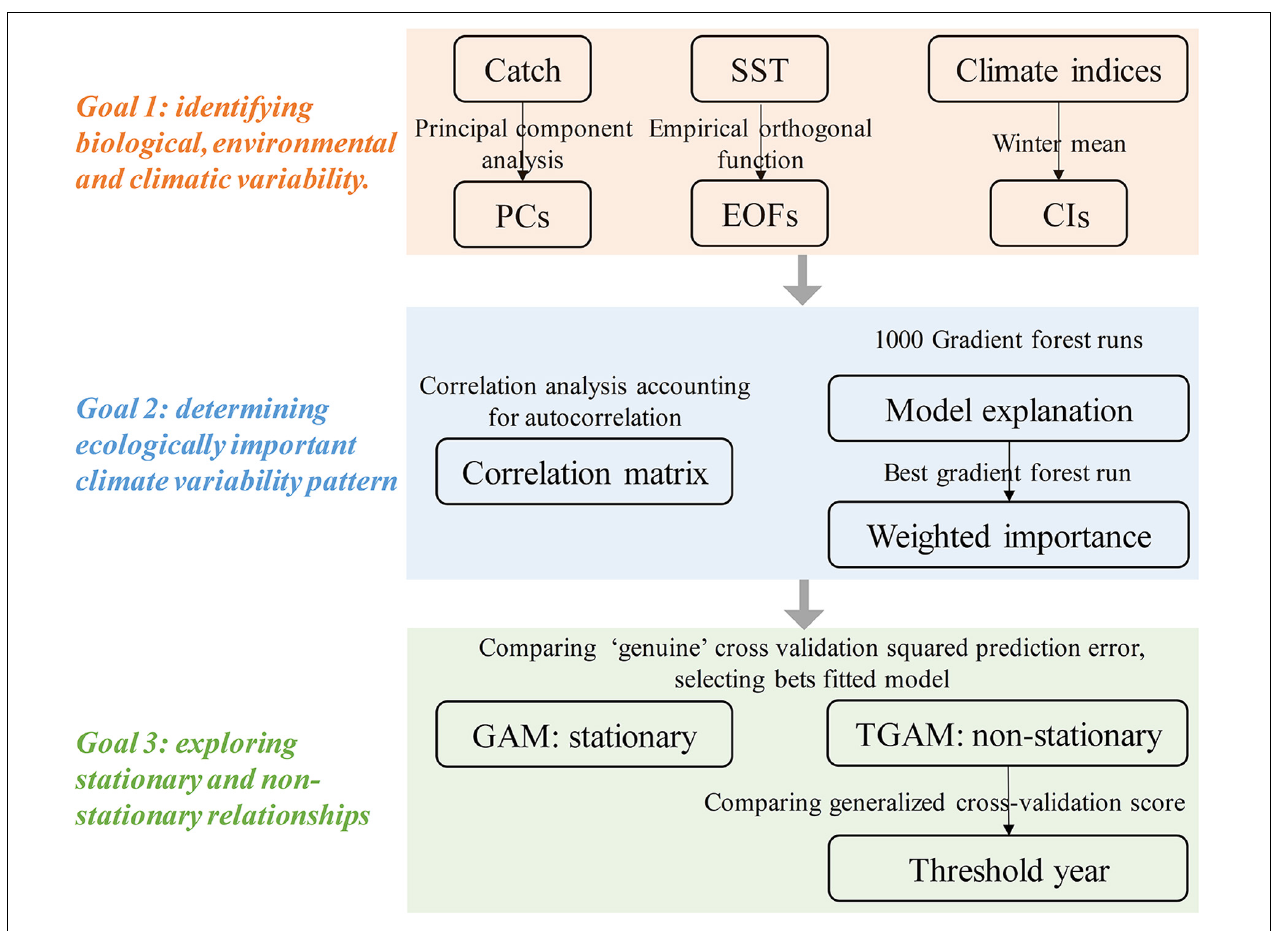
FIGURE 2 | Flow chart of the statistical analyses conducted in this